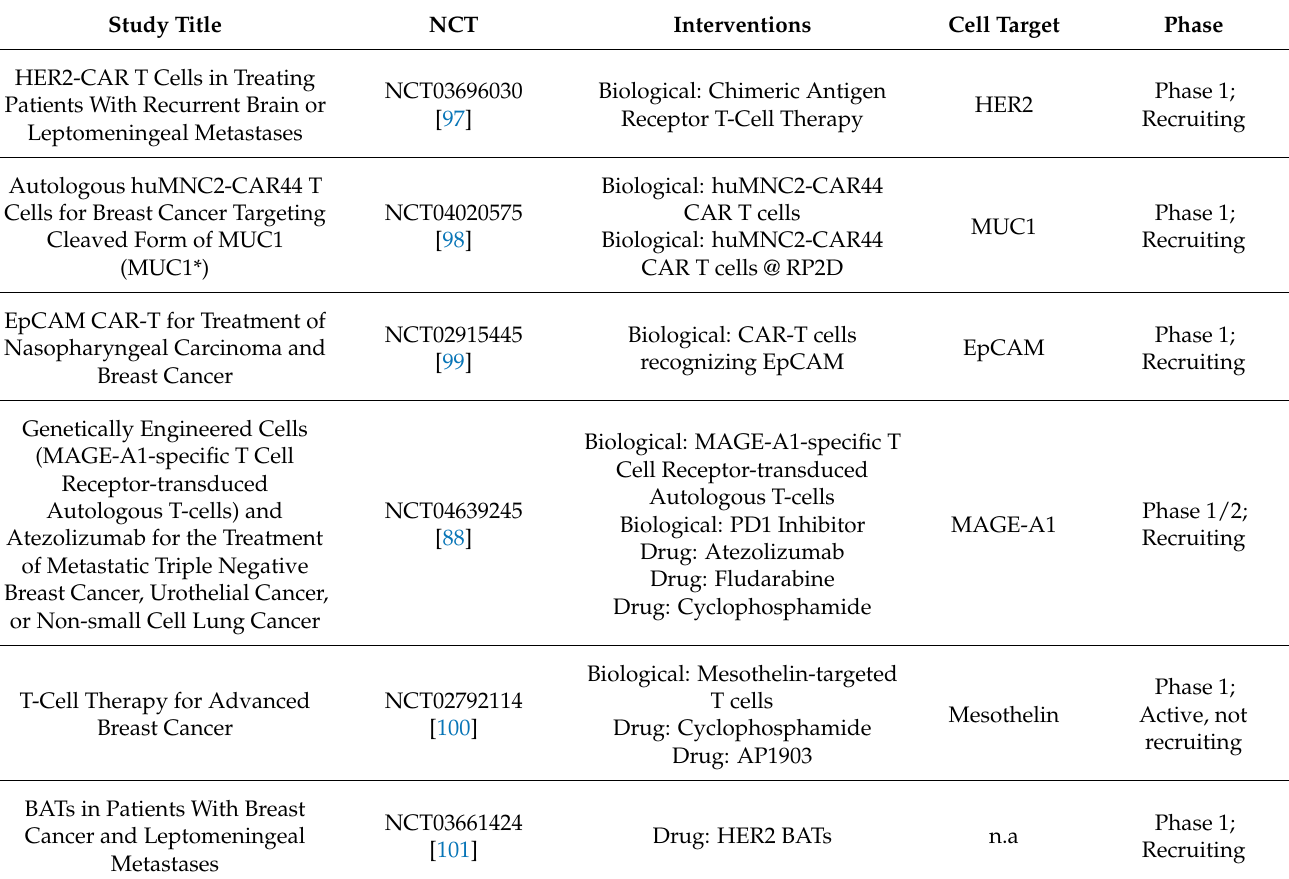
Table 1. Summary of recent active clinical trials using cellular immunotherapy against breast cancer as a monotherapy or in combination approaches with checkpoint inhibitors or chemotherapy. Clini- caltrials.gov, accessed March 2022, search terms used were “cellular immunotherapy” and” breast cancer”, with the search criteria focusing on recently added studies in early phases using cellular immunotherapy against breast cancer excluding vaccination